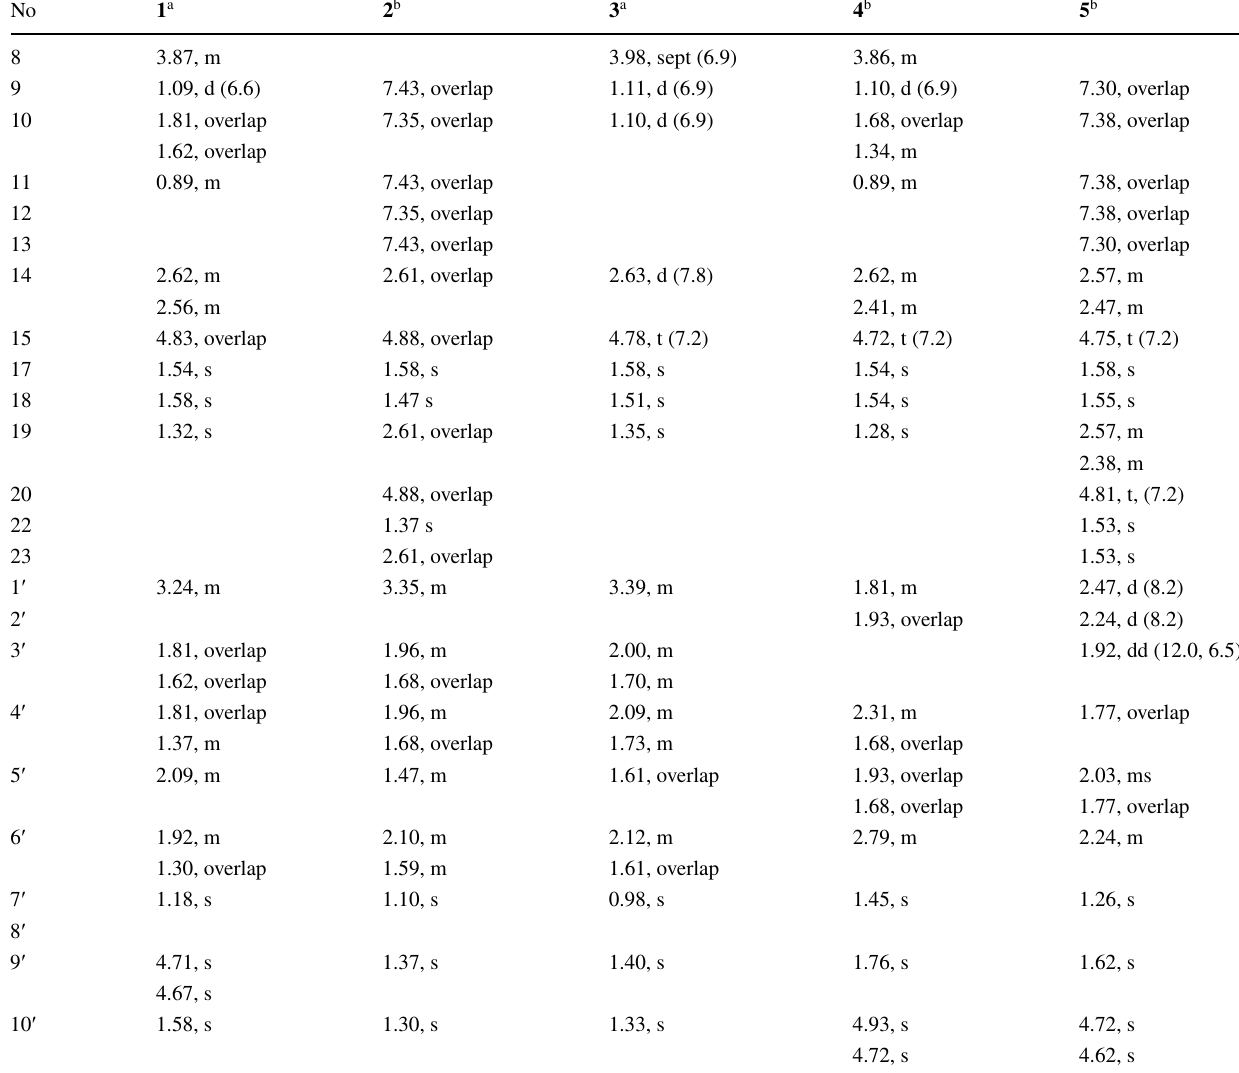
Table 2 The 1 H (600 MHz) NMR data of compounds 1 – 5 ( δ in ppm and J in Hz)